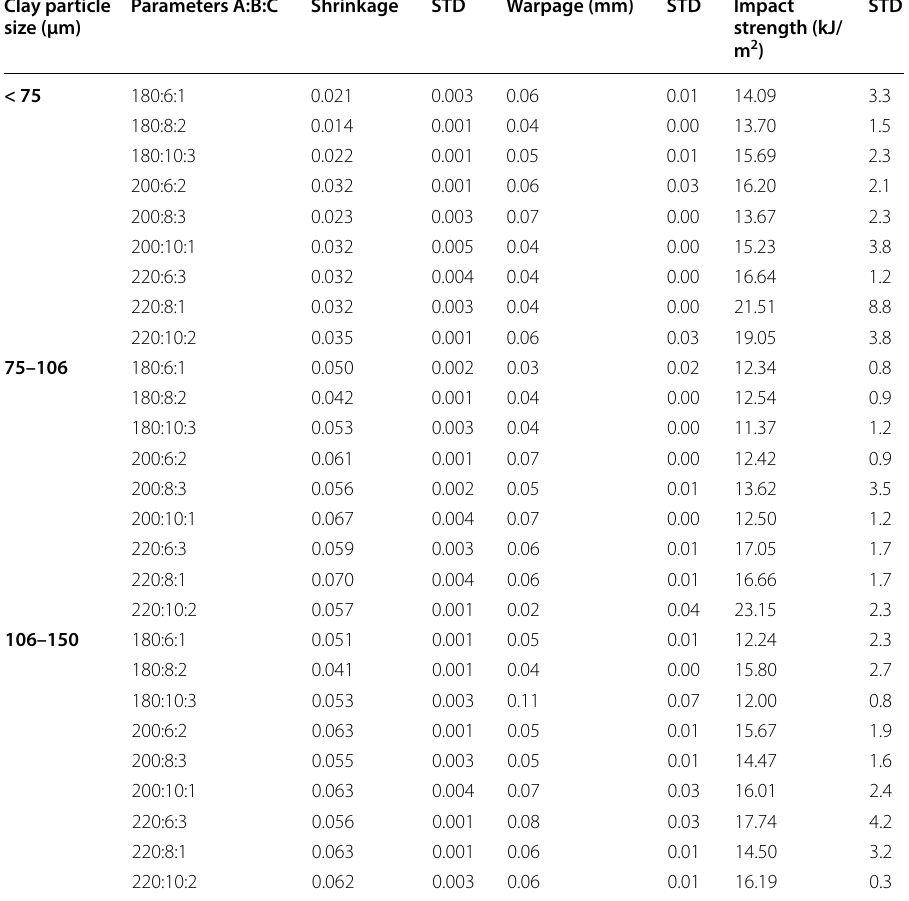
Table 3 Shrinkage, warpage and impact strength of HDPE/KC composites with different clay sizes for each trial, which were obtained experimentally Clay particle size